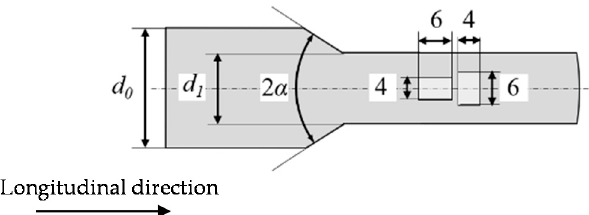
Figure 1. Schematic visualization of specimens used for cyclic compression tests, and extraction position. All dimensions are in mm.